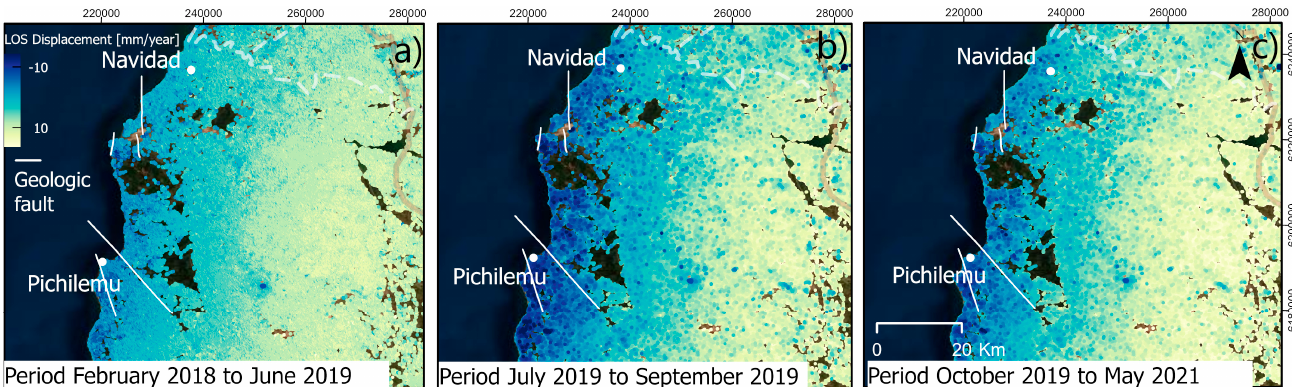
Figure 12. Comparison LOS displacement for Navidad and Pichilemu areas ( a ) pre-earthquake: